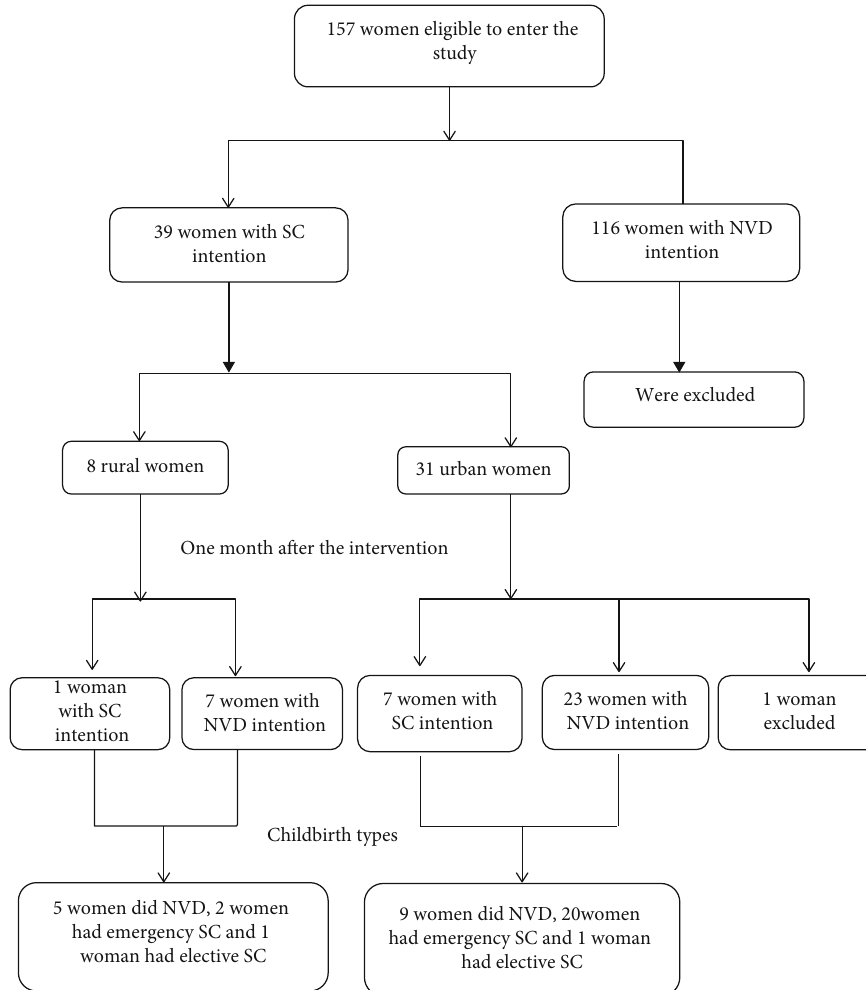
Figure 1: Study fl